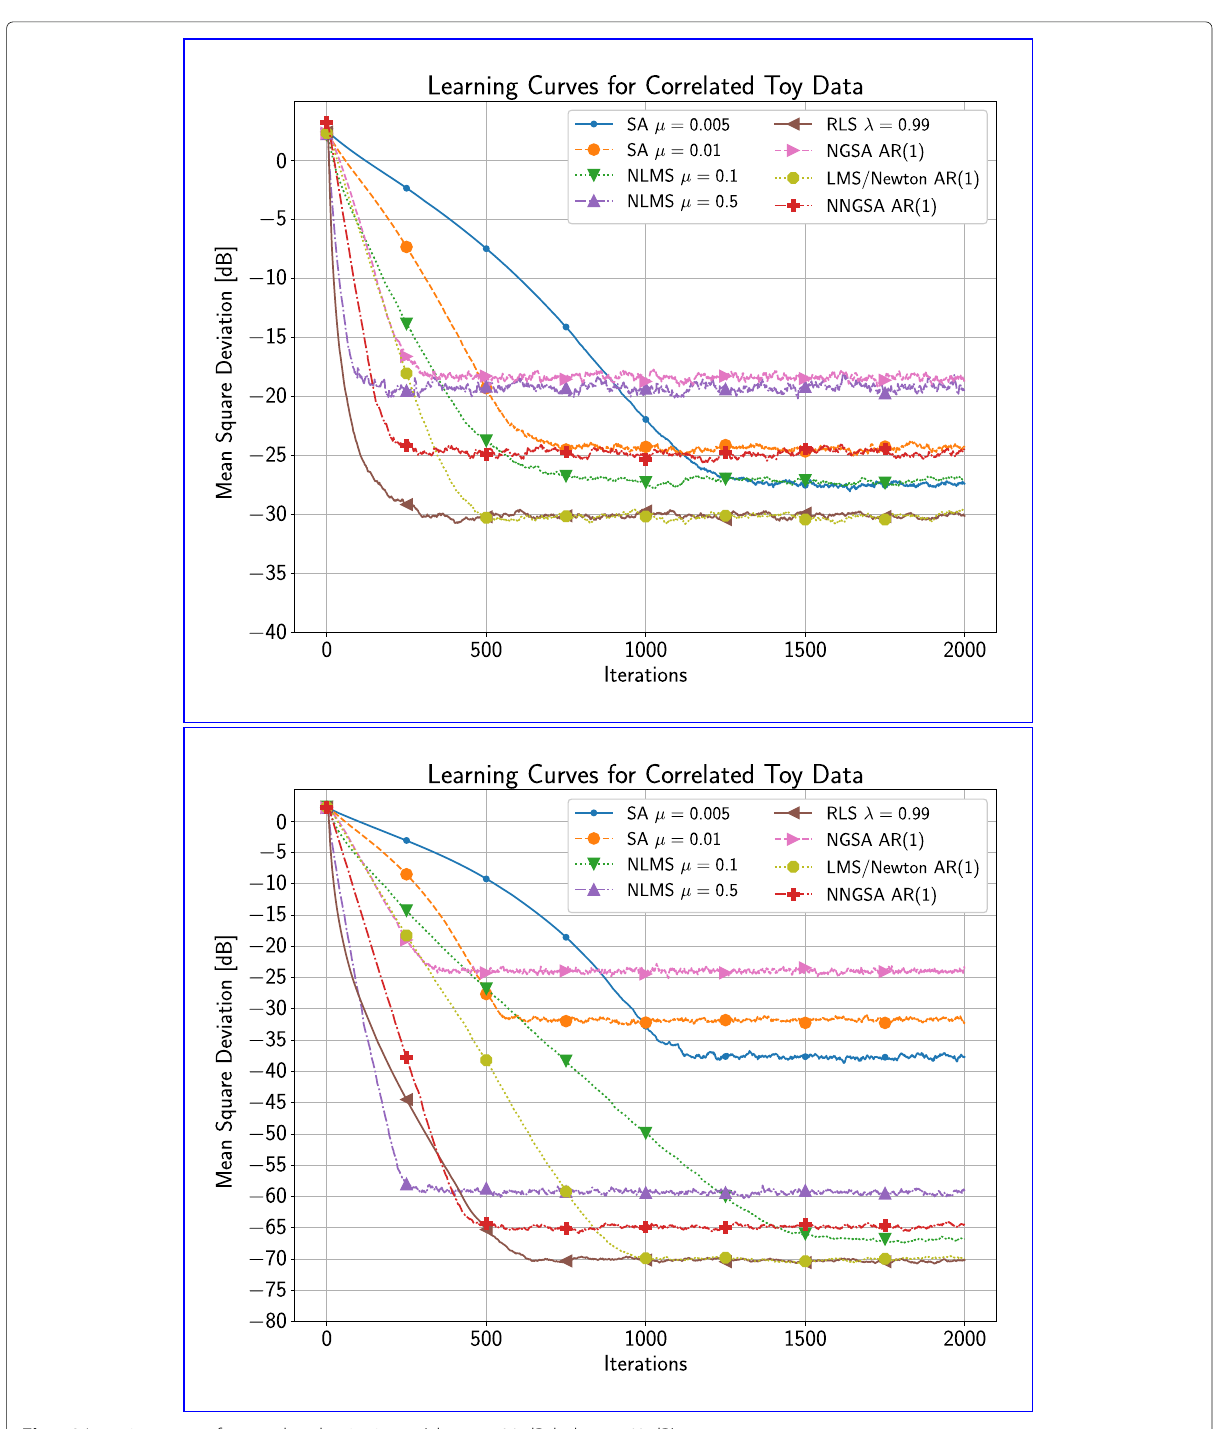
Fig. 10 Learning curves for correlated noise input (above: − 20 dB, below: − 60